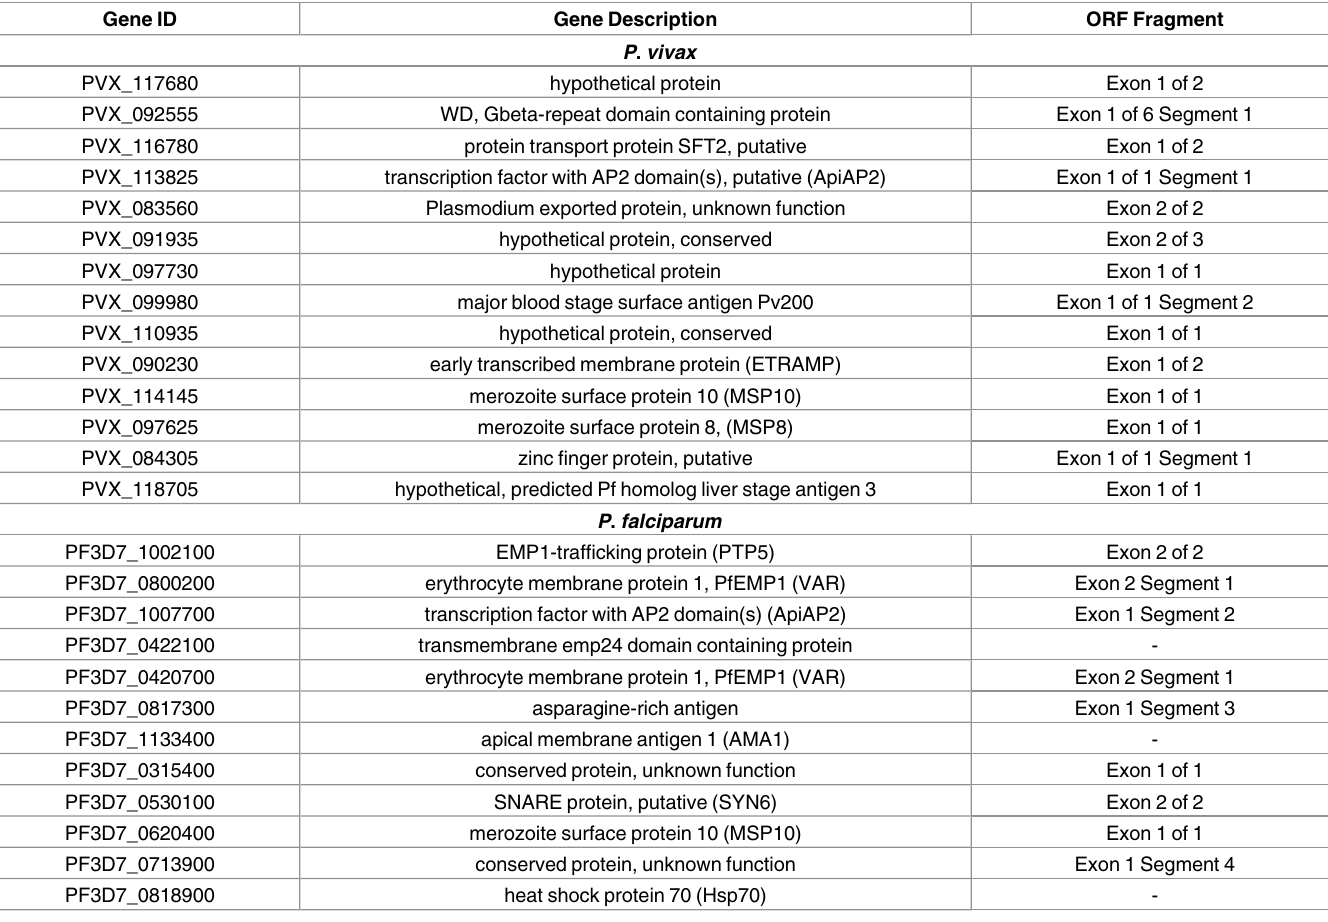
Table 2. Top immunogenic Plasmodium